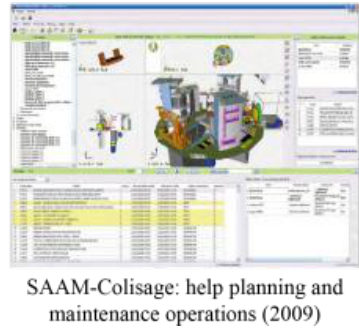
Figure 1: ADRM and SAAM-Colisage rely on as-built data to help maintenance operations in nuclear plants at EDF. For these current surveys, TLS data are typically acquired through a few stations (up to 50). Registration and referencing, in a specific datum related to the plant, are performed with a 1 cm error tolerance. Total stations are used for traversing some targets used in the referencing, as described in (Hullo et al., 2011).